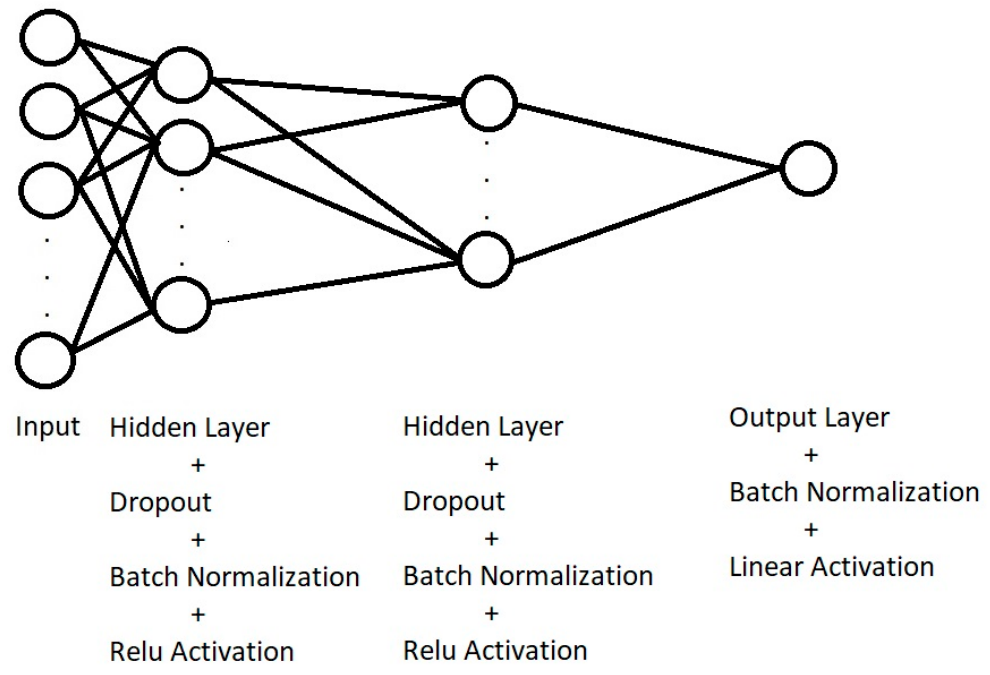
Figure 3. Multilayer Perceptron architecture.